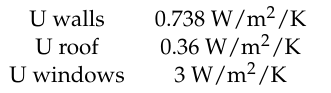
Table A4. Assumed overall heat transfer coefficient values